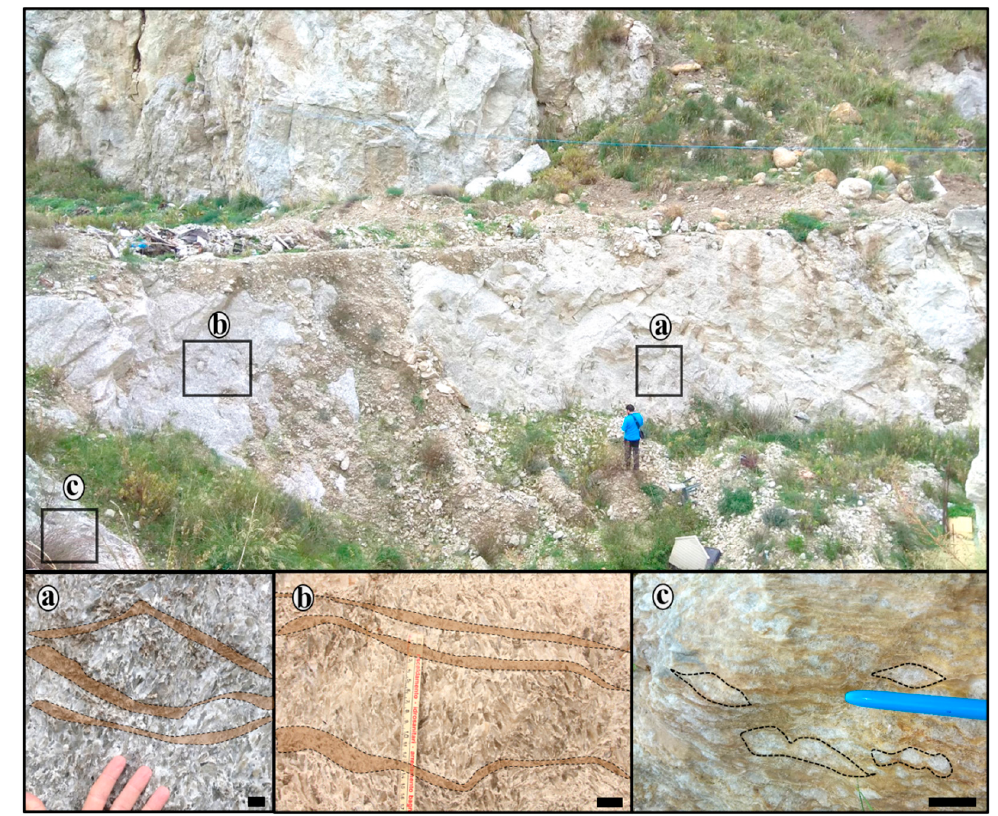
Figure 2. Panoramic view of the Benestare’s quarry and sampling sites ( a – c ); ( a ) branching-like facies made of elongated gypsum nodules (black dashed lines) within the laminated matrix (grey colour); ( b , c ) gypsrudites intervals (vertically repeated) showing variable thickness, and interbedded by thin argillaceous/calcareous laminae (in brown colour). Scale bar is 2 cm.